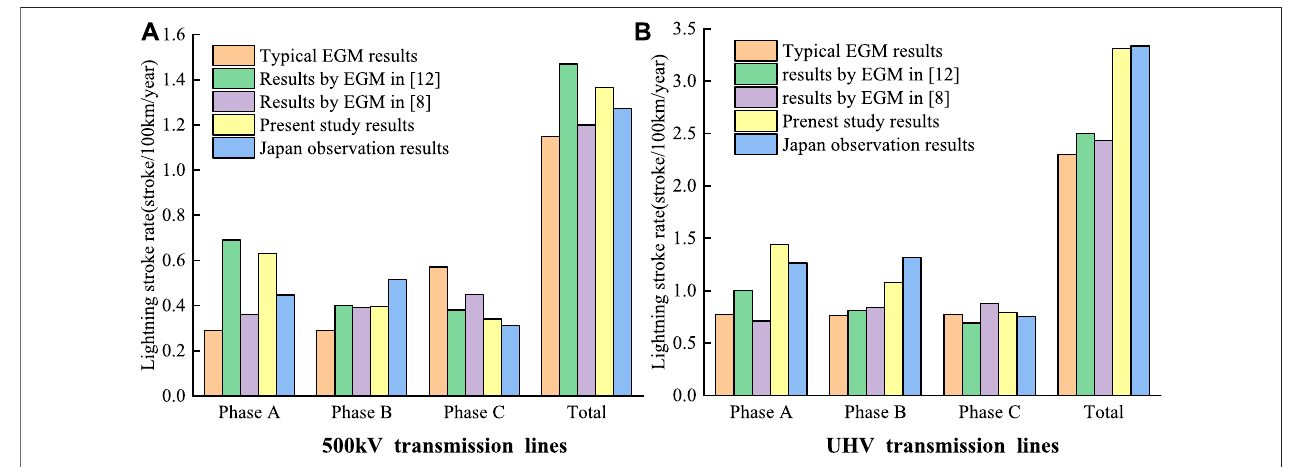
FIGURE 5 | Comparison of different lightning stroke rate calculation methods with actual observation data. (A) 500 kV transmission lines. (B) UHV transmission lines.